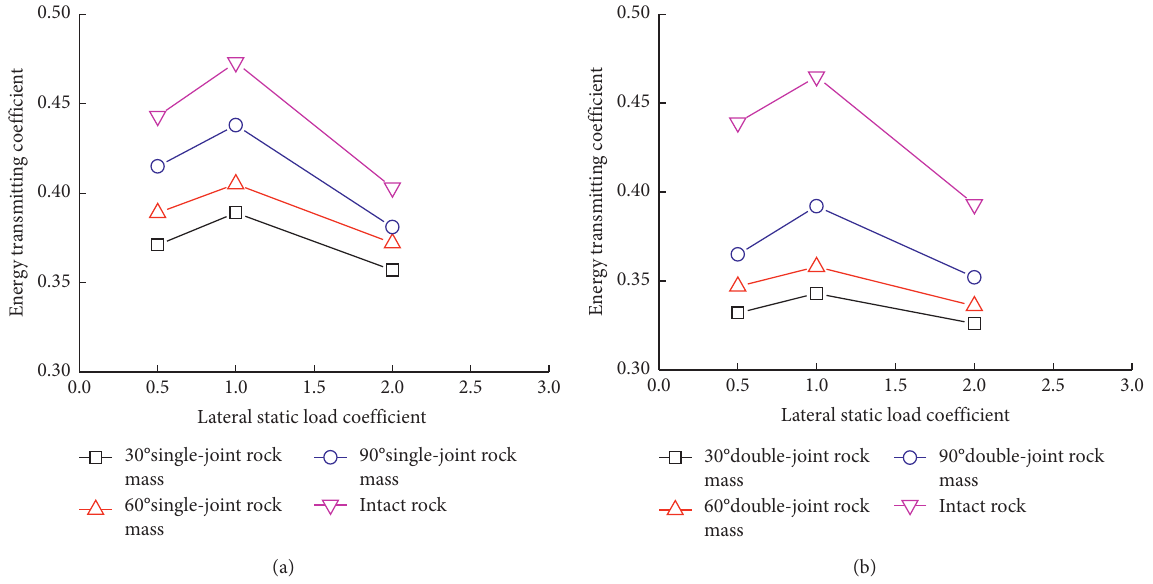
Figure 17: Energy transmitting coefficients of blasting stress wave in jointed rock masses under different lateral static load coefficients. (a) Single-joint rock mass. (b) Double-joints rock mass.